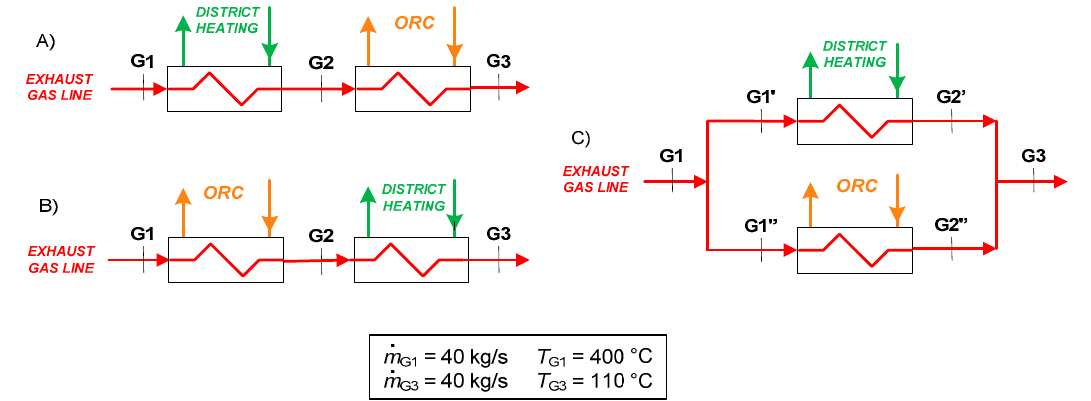
Figure 6. Schematic of the proposed DH and intermediate heat transfer fluid (IHTF) heat exchangers